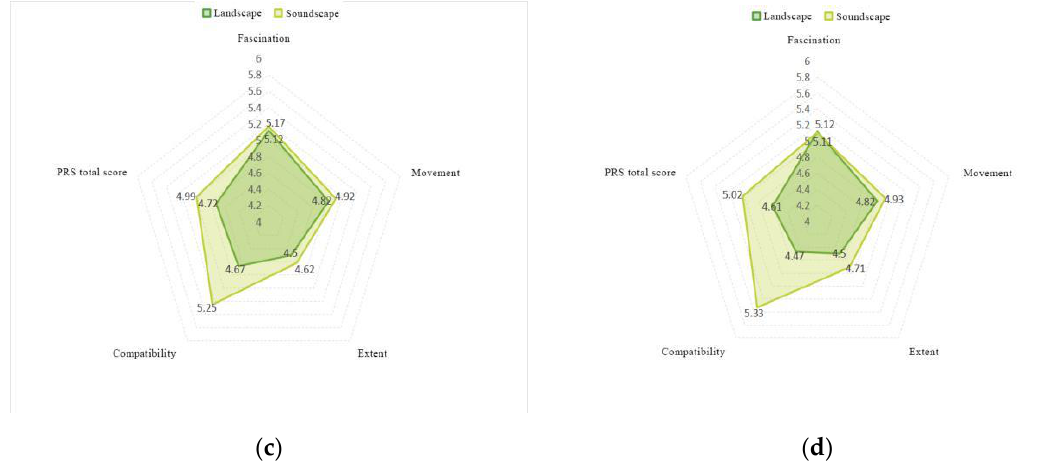
Figure 8. Restorative benefits observed for different paths: ( a ) water's edge (waterfront space), ( b ) water's edge (wetland), ( c ) waterfront space and wetland, and ( d ) clearing in the woods.